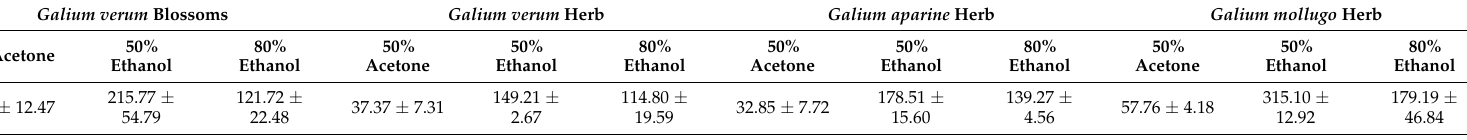
Table 3. Quantification of phytochemicals in Galium extracts